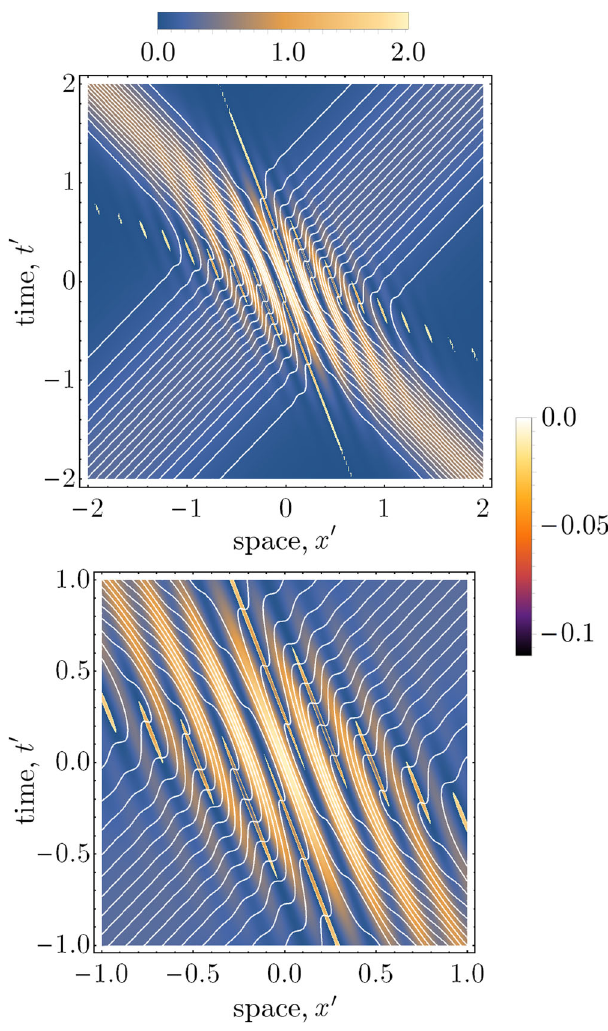
Fig. 6 Bohmian trajectories in the head on limit, viewed from a boosted reference frame with v = 0.4, k 0 / σ = 15, and α = 1/2. The trajectories are superimposed over the corresponding Klein – Gordon density, where the respective legends show the magnitude of the positive and negative density regions. The backwards-in-time trajectories are consistent with our interpretation of the Bohmian velocity fi eld as a coordinate velocity constructed via weak measurements in a particular reference frame. The lower panel shows a zoomed-in view of the